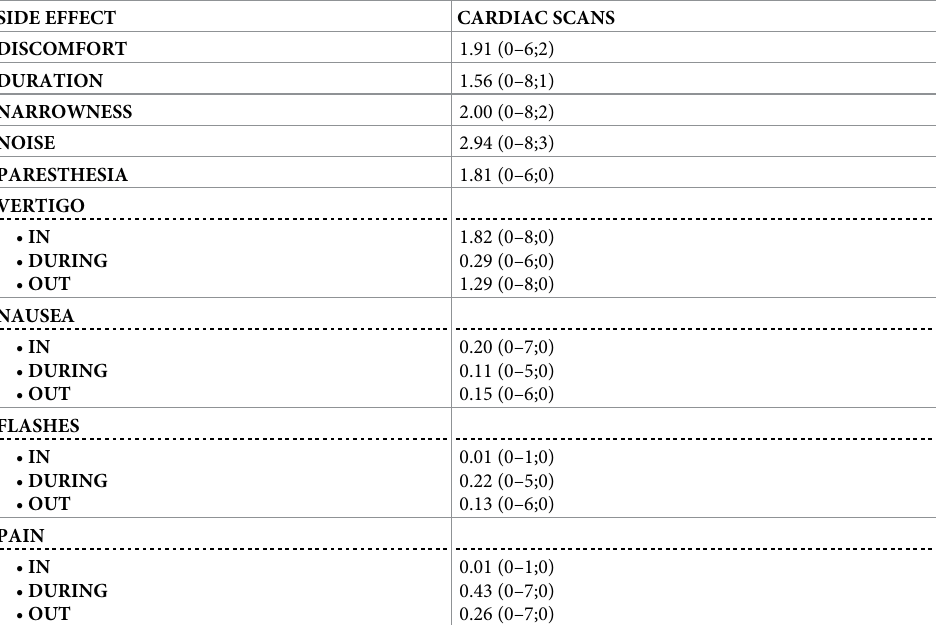
Table 5. Subjects’ acceptance of brain and cardiac scans at ultra- high field